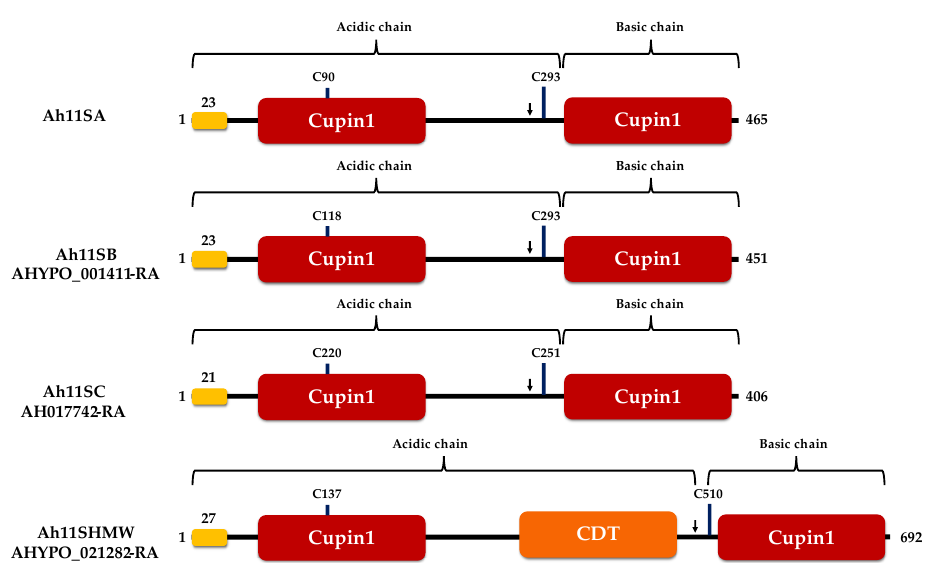
Figure 2. Conserved domains in amaranth 11S globulins. The arrow in each diagram indicates the proteolytic processing Asn-Gly site. The signal peptide is indicated in yellow. Cysteine residues forming the disulfide bond between the acidic and basic subunits are indicated.